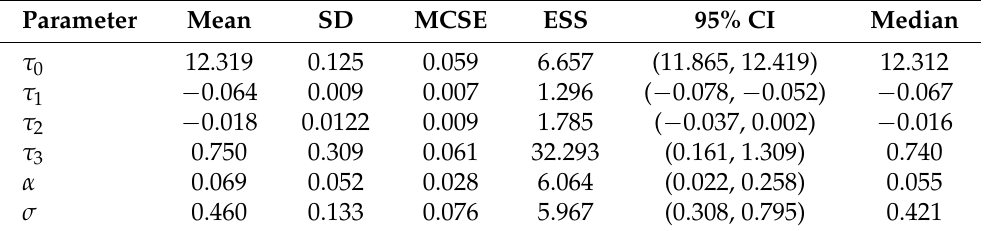
Table 17. GDUSLN Bayesian regression results on Stanford heart transplant